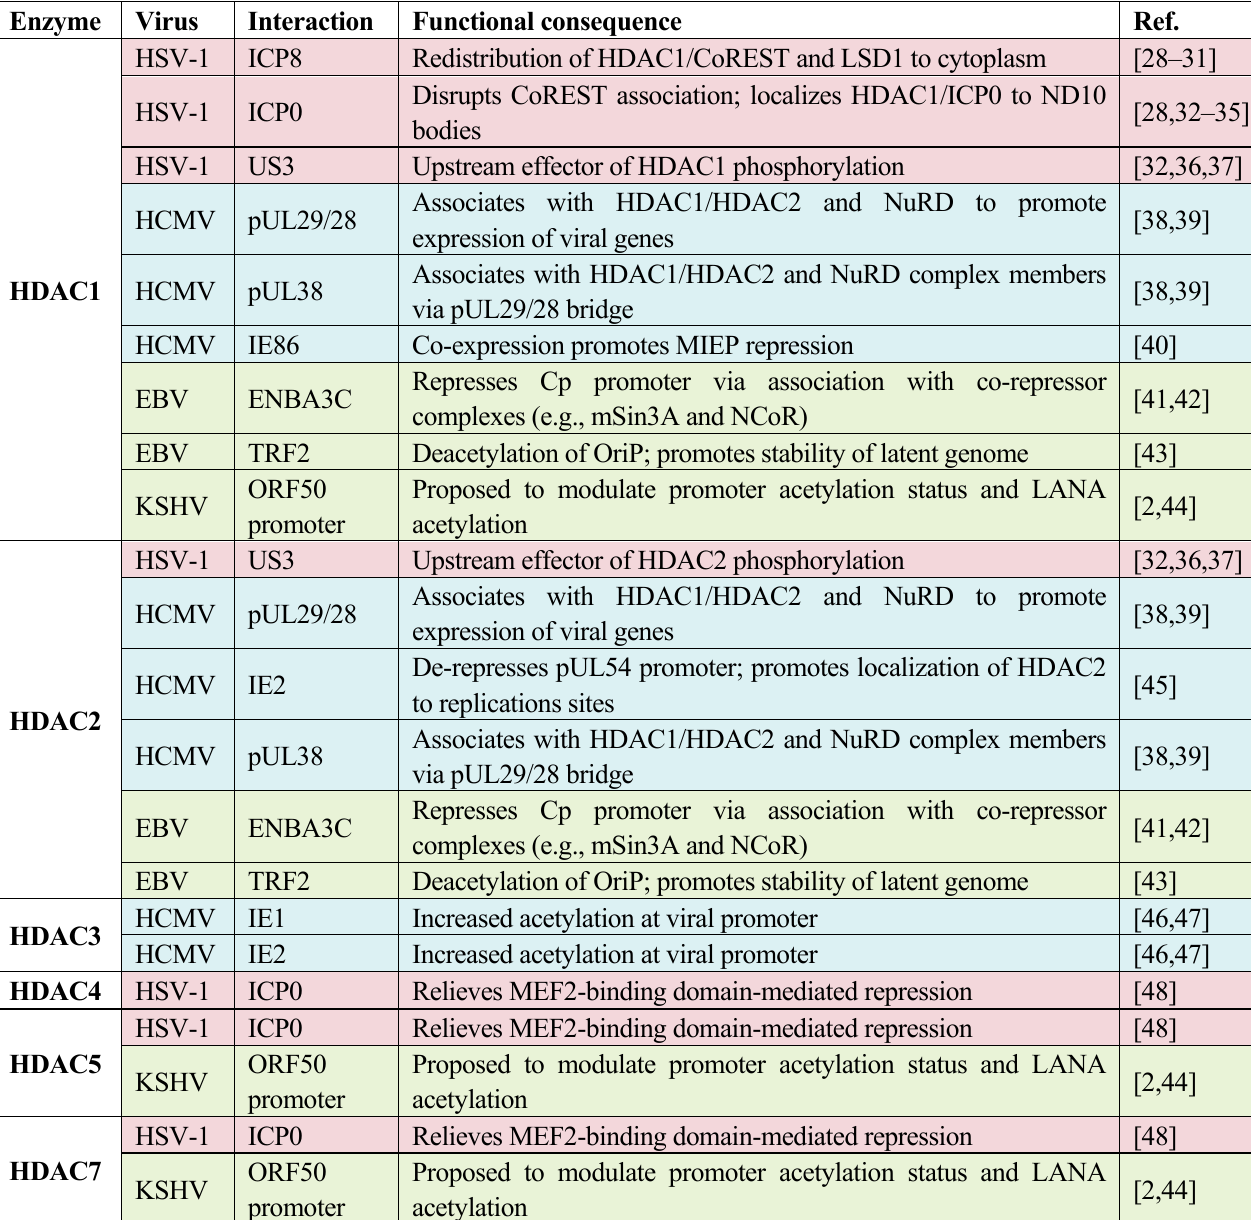
Functional consequence